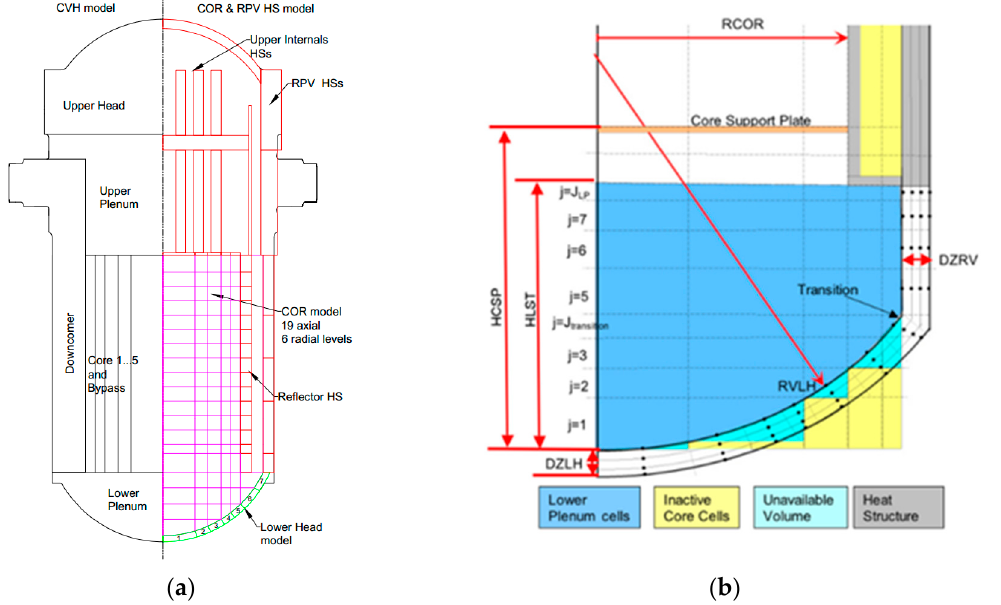
Figure 4. MELCOR RPV modelling ( a ), where the lower head model is the hemispherical green-coloured structure. Right ( b ) presents general MELCOR lower plenum model [17].